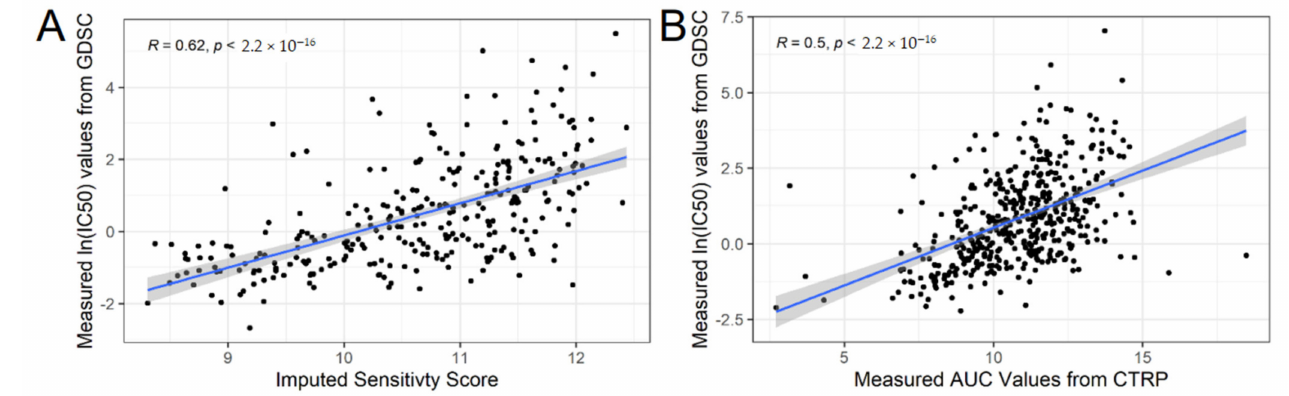
Figure 3. Correlation of Wee1 inhibitor predicted and actual cell line response to AZD-1775 in an independent in vitro dataset. ( A ) For each cell line in GDSC not present in CTRP (i.e., cell lines unique to GDSC), imputed drug response to AZD-1775 using the CTRP imputation model (x-axis) is graphed against the reported GDSC IC50 sensitivities (y-axis). Spearman-rank correlation ( R ) and p -value as reported. ( B ) For each cell line in common between GDSC and CTRP, the measured IC 50 values from GDSC (y-axis) is graphed against to the measured AUC values from CTRP (AUC values are used to build the imputation model). Spearman-rank correlation and p -value as indicated. ( B ) serves as a point of comparison for how consistent two completely independent measured datasets are compared to the consistency of our imputed values built in one dataset to the measured values of the other ( A ). Abbr: GDSC, Genomics of Drug Sensitivity in Cancer; IC50, Half maximal inhibitory concentration; AUC, Area Under the dose response